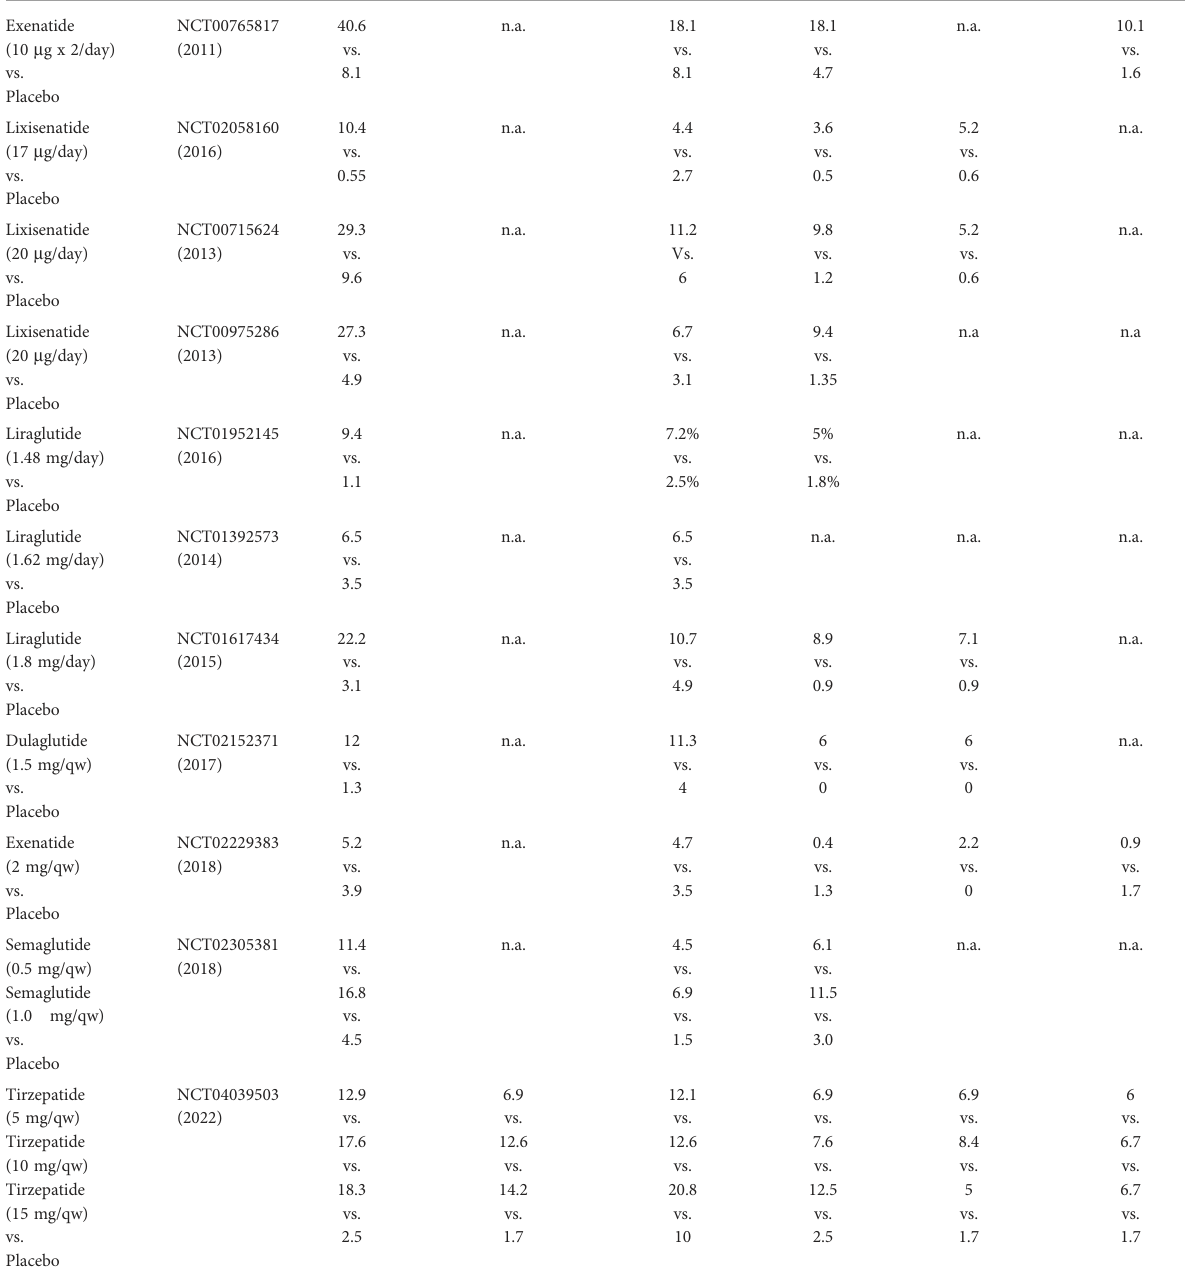
TABLE 3 Summary of the most common reported adverse events displayed by molecules and